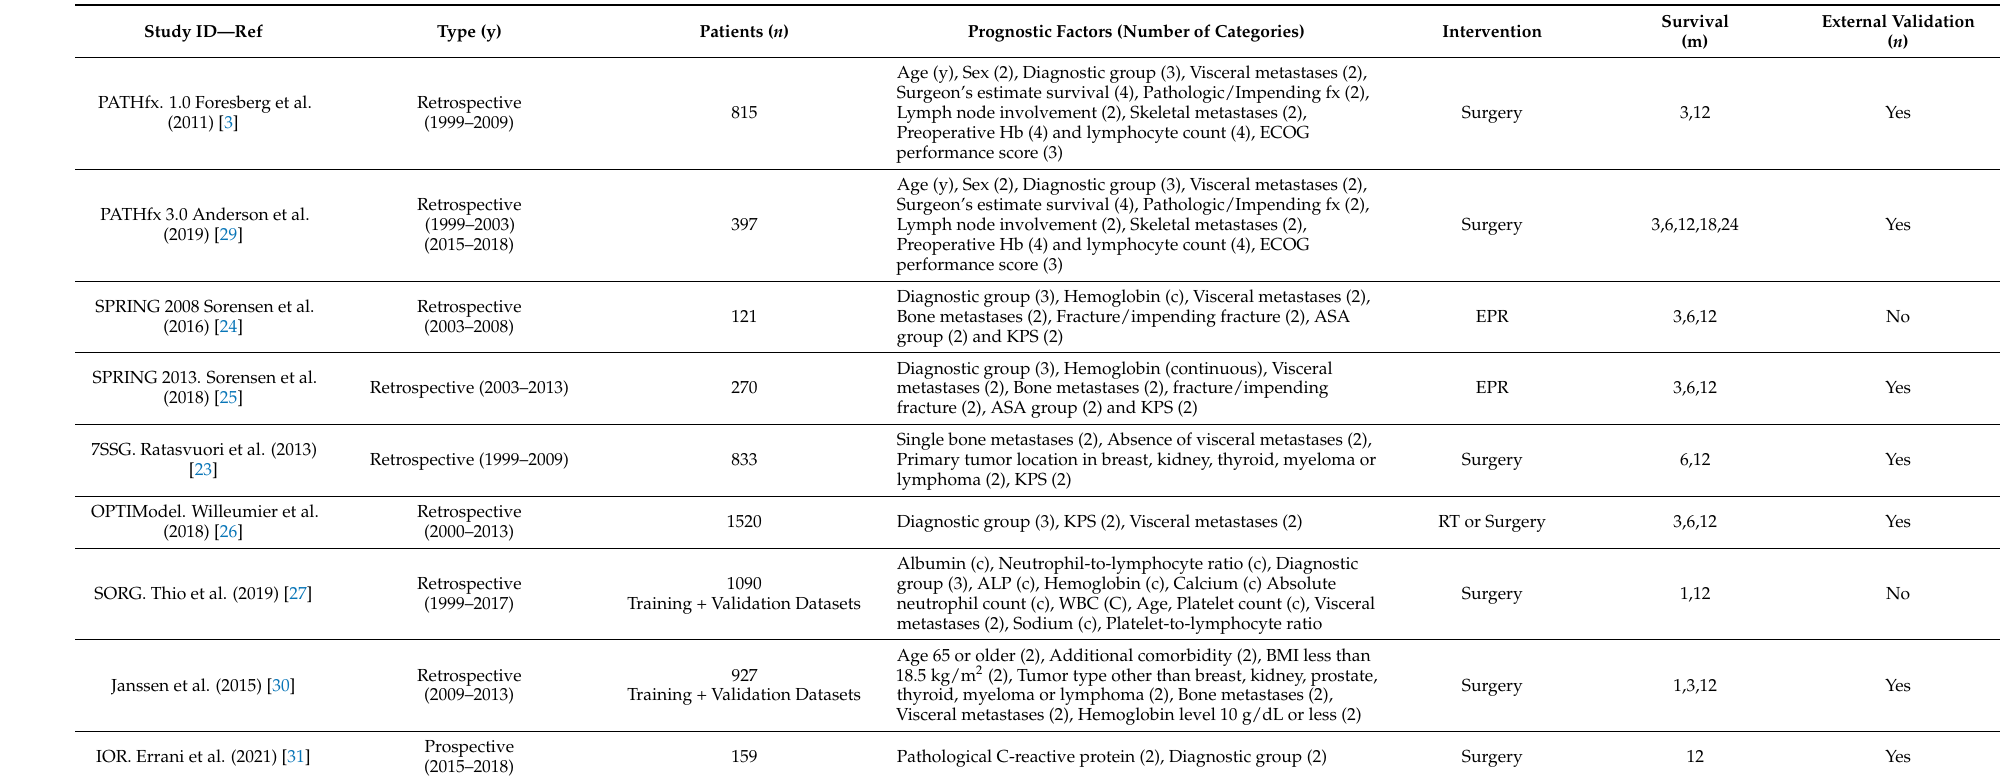
Table 1. Summary of Included Scoring